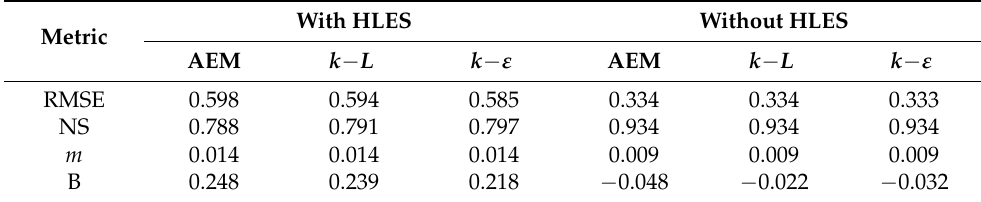
Figure 10. Data dispersion between RS temperatures and simulated temperatures at monitor points for different turbulence closure models: ( a ) with HLES; ( b ) without HLES. Table 6. Error criteria for each turbulence